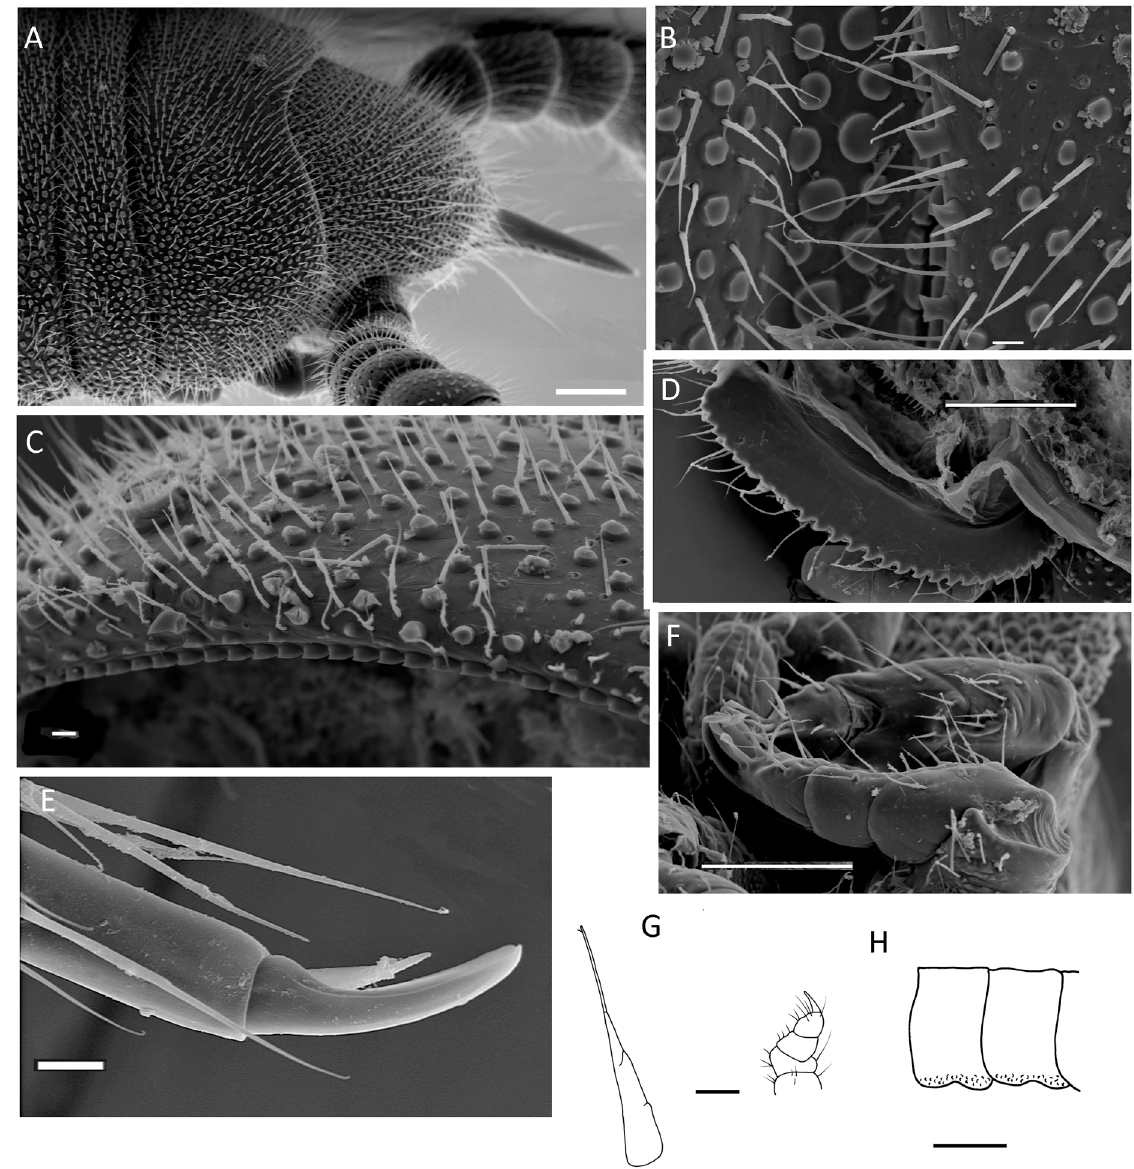
Fig. 6. Columbianum adisi sp. nov. A . Head and first few rings of male in dorsal view. B . Dorsal view of midbody ring from male showing detail of tubercles. C . Dorsal view of midbody ring from male showing detail of limbus. D. Midbody ring from male showing hind edge of pleurite from the inside. E . Midbody claw and accessory claw from male in posterior ventral view. F . Male anterior gonopods in situ . G . Male gonopods in lateral view, posterior (left) and anterior (right). H . Lateral view of pleurites from front end of female paratype. Anterior to left. Scale bars = A, D, F = 0.1 mm; B–C, E = 0.01 mm; g–H = 0.2